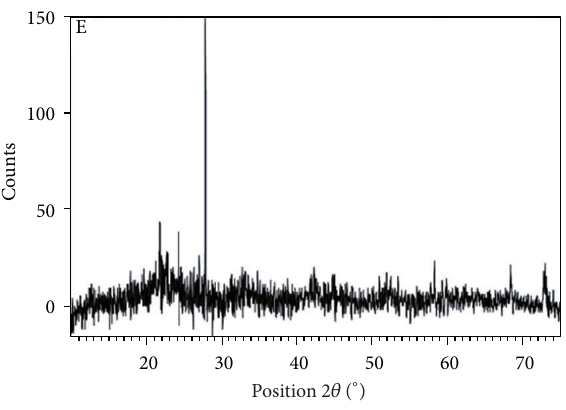
F 1: X-ray diffraction pattern of ZIWSC.